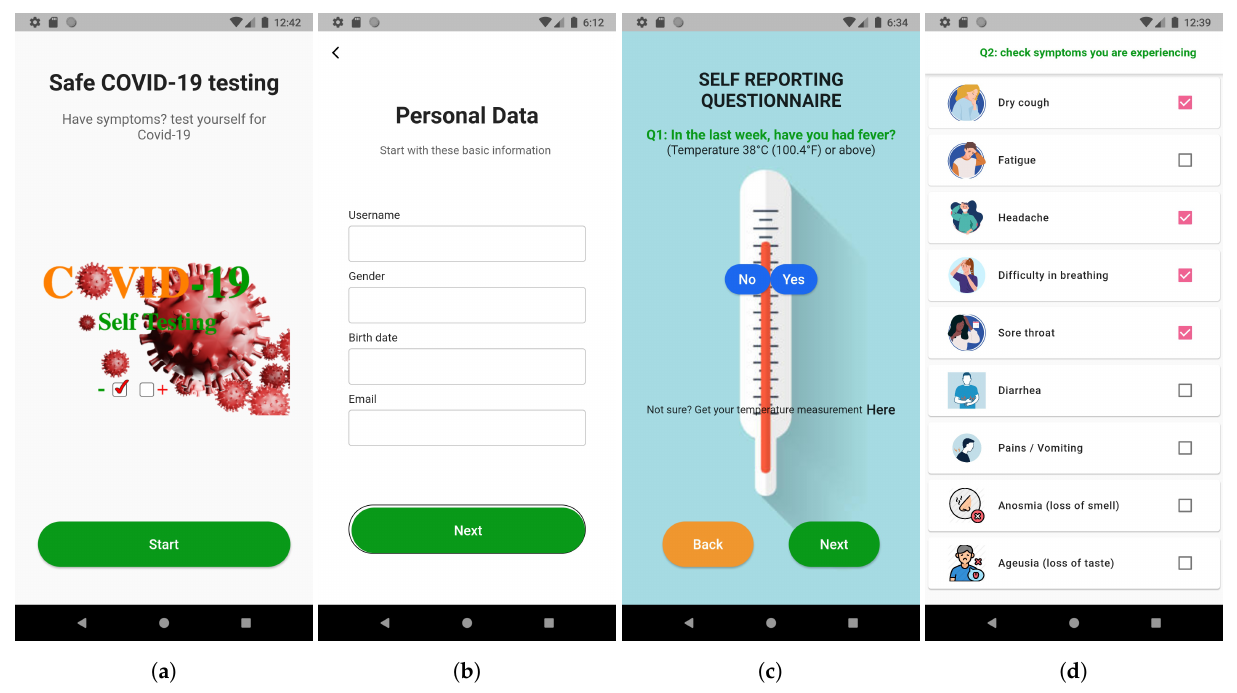
Figure 3. Snapshots of the app designed for data collection and prediction, ( a ) initial screen; ( b ) particulars screen; ( c ) temperature reporting; and ( d ) symptoms